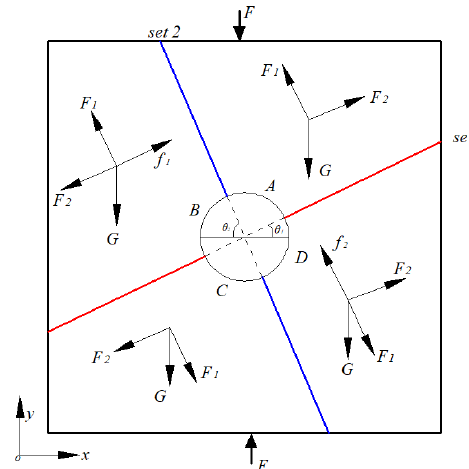
Figure 15. The mechanics of rock mass under two sets of structural planes. A, B, C, and D are the rock blocks cutting by structural planes.